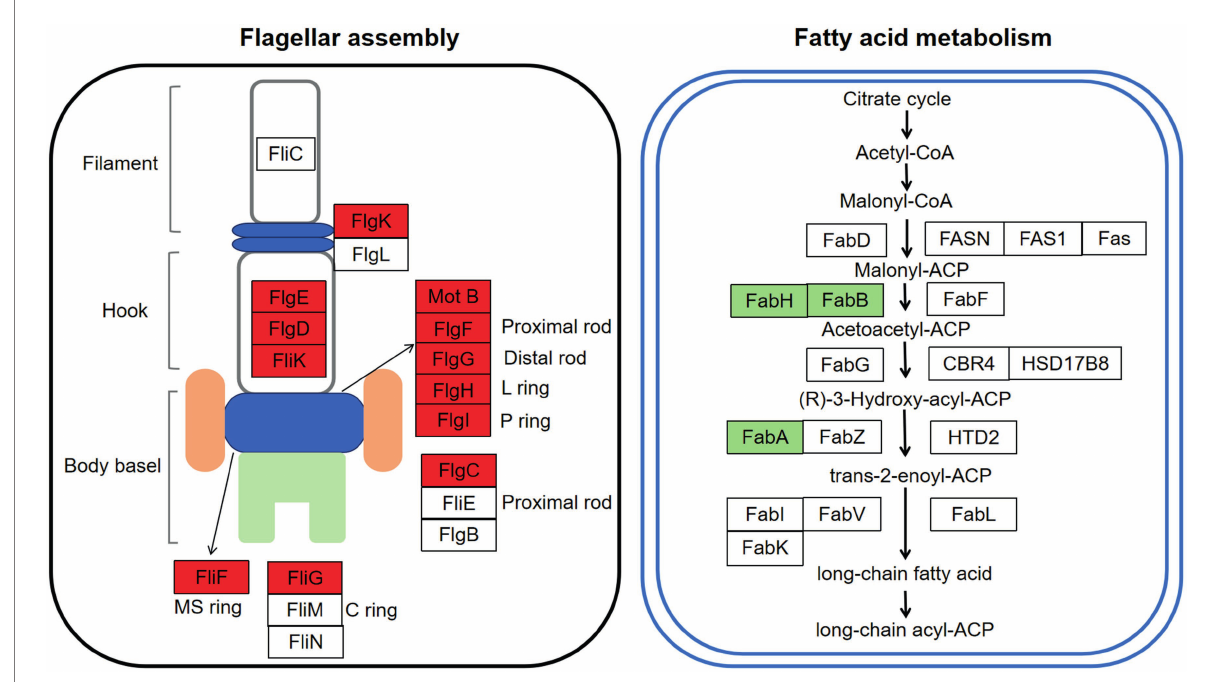
FIGURE 7 Changes of the expression levels of genes involved in flagellar assembly and fatty acid metabolism of Shewanella baltica . The genes marked in red and green represented upregulation and downregulation in rpoS